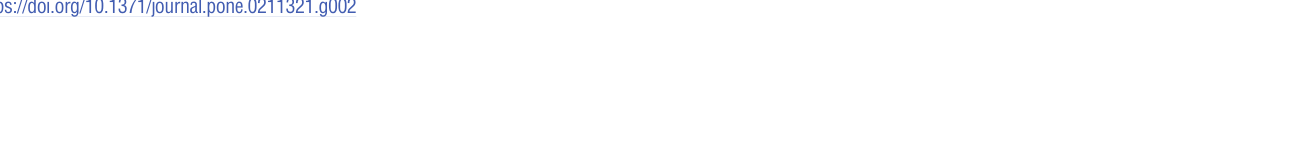
PLOS ONE | https://doi.org/10.1371/journal.pone.0211321 February 13,